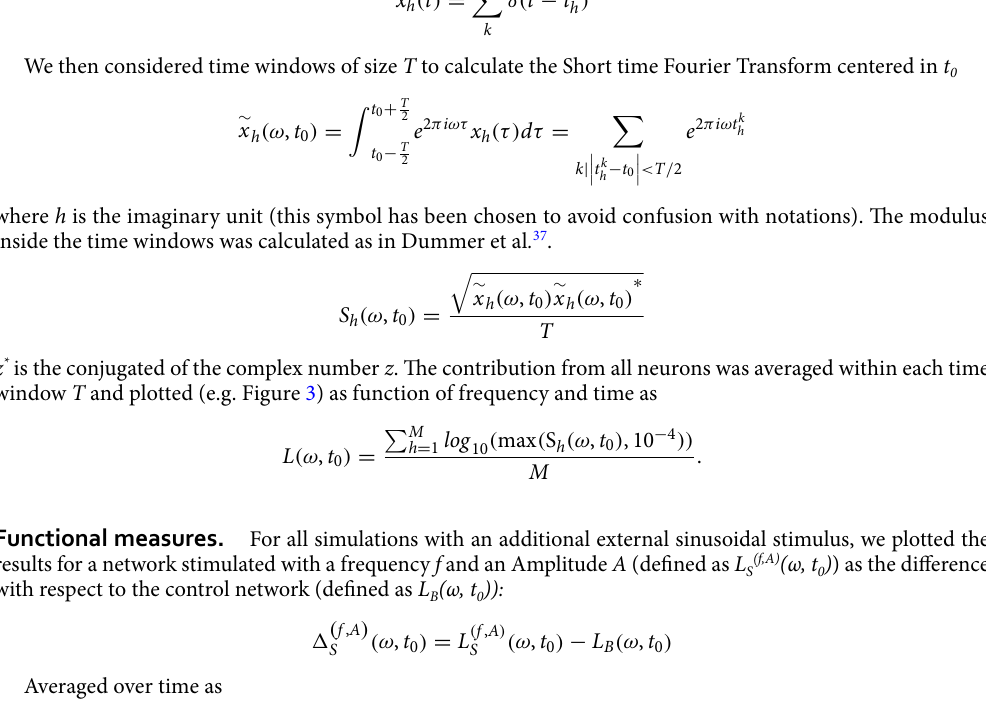
Figure 6. Fitting the degree distributions observed in different brain networks. In all cases the model (orange bars) represent the fit of the experimental findings (blue bars) using the algorithm described in Giacopelli et al. 26 complemented, when available, with distance-dependent information 27 . The parameters used for each case are (see “Methods” for symbols): ( A ) two blocks configuration with δ = 1.5 ± 0.5, E k = 1 ± 0.5, L = 1, η = 3 ± 0.25, φ u = 1 and φ d = 0 ± 0.00001; ( B ) Two blocks asymmetric configuration with δ = 0 ± 2, E k = 0.1 ± 0.05, L = 1, η = 3 ± 0.25, φ u = 0.75 and φ d = 0 ± 0.001; ( C ) Two blocks (with one block inverted) configuration with δ = 0 ± 0.5, E k = 70 ± 0.05, L = 3 ± 0.75, η = 3 ± 0.25, φ u = 1 and φ d = 0 ± 0.001; ( D ) The model is composed by 4 components with a 6-layers structure each composed by 9 blocks: Excitatory-Excitatory component, with parameters δ = 3 ± 0.5, E k = 100 ± 0.5, L = 100 ± 0.5, η = 3 ± 0.25, φ u = 1 and φ d = 0.0001 ± 0.00001; Excitatory-Inhibitory component, with parameters δ = 4.52 ± 1, E k = 6.8 ± 0.5, L = 6 ± 1, η = 2.56 ± 0.5, φ u = 1 and φ d = 0.0003 ± 0.00025; Inhibitory-Inhibitory component, with parameters δ = 1 ± 0.5, E k = 3 ± 0.5, L = 4 ± 1, η = 3 ± 0.25, φ u = 1 and